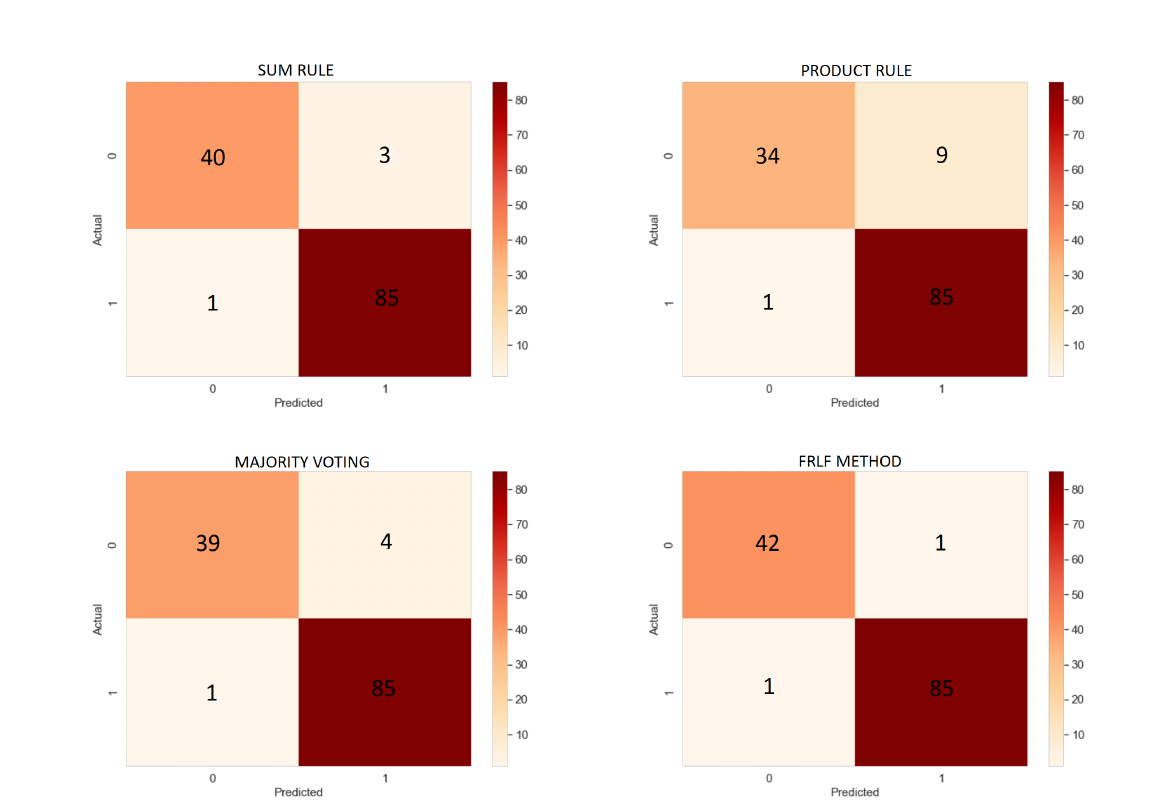
Figure 11. Confusion Matrices of Ensemble method.